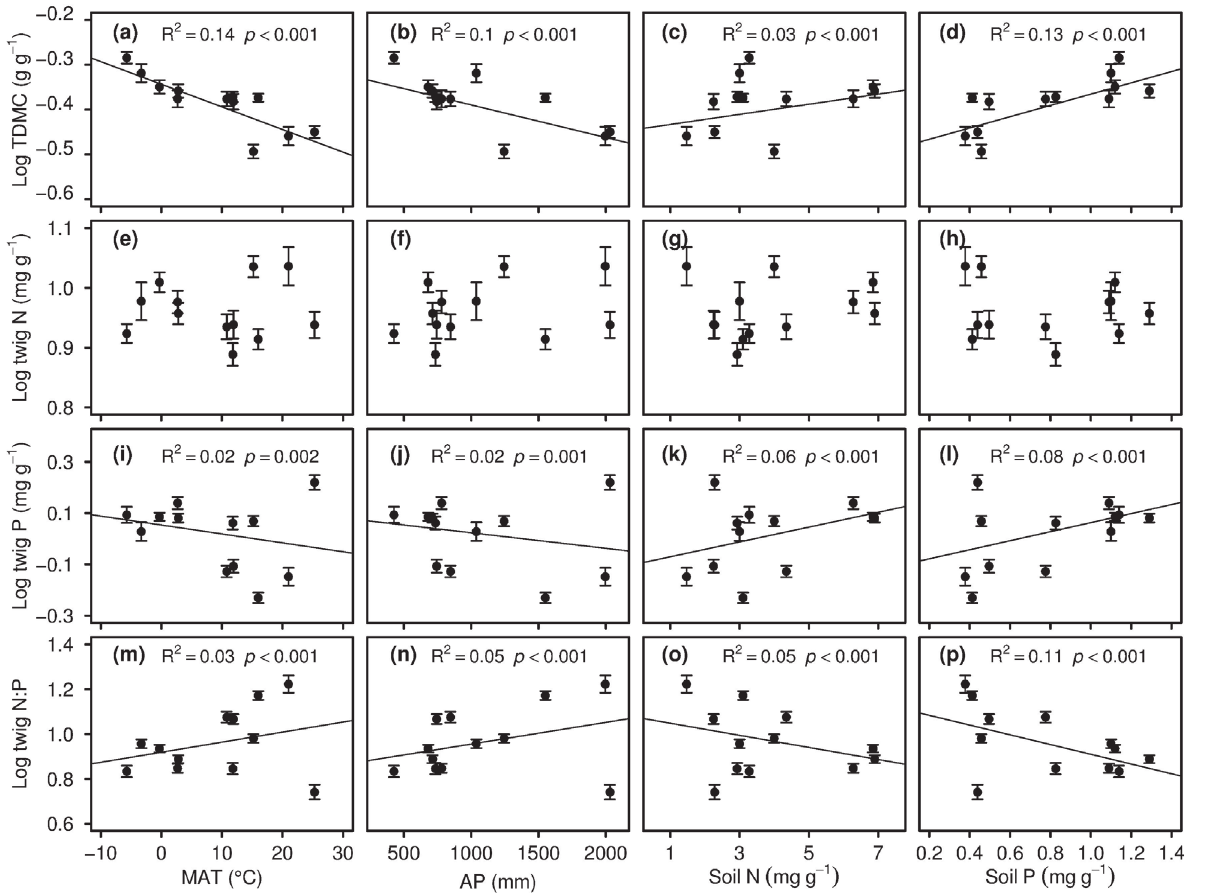
Figure 3. Changes in site-averaged twig TDMC, N, P and N: P along mean annual temperature (MAT), annual precipitation (AP), soil N and soil P. (a-d) twig TDMC; (e-h) twig N; (i-l) twig P; (m-p) twig N:P. Regression lines are fit to the raw data with p < 0.05. Points and error bars stand for the means and standard errors of the twig